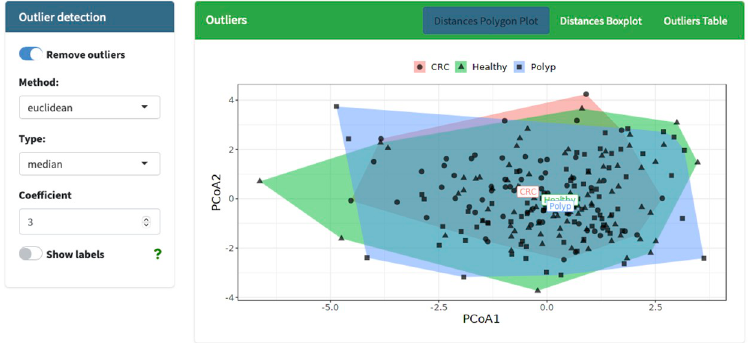
Fig 2. Screenshot of the “Outlier detection” panel showing the Euclidean distances in principal coordinate space between samples and their respective group centroid. ST000284 example data were used to create this plot.